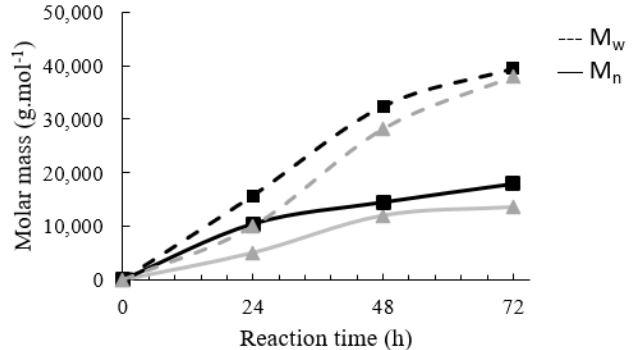
Figure 2. Molar mass of the polymers synthesized from the hydrogenated monomers. 5a , 5b .